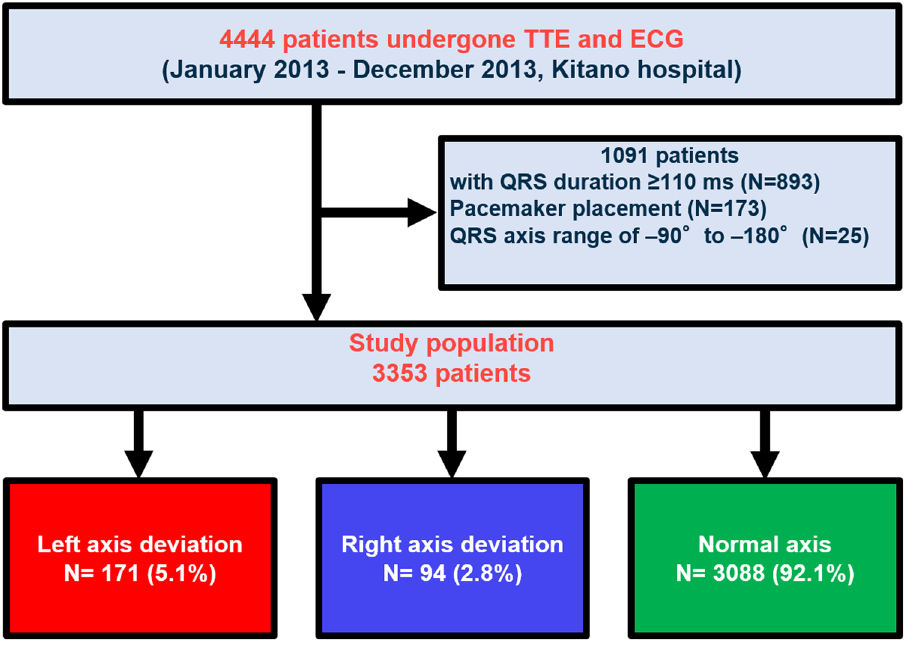
Figure 1. Patient flowchart. TTE transthoracic echocardiography, ECG